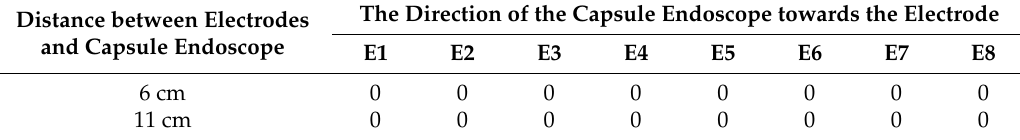
Table 4. BER performance of the CEHBC